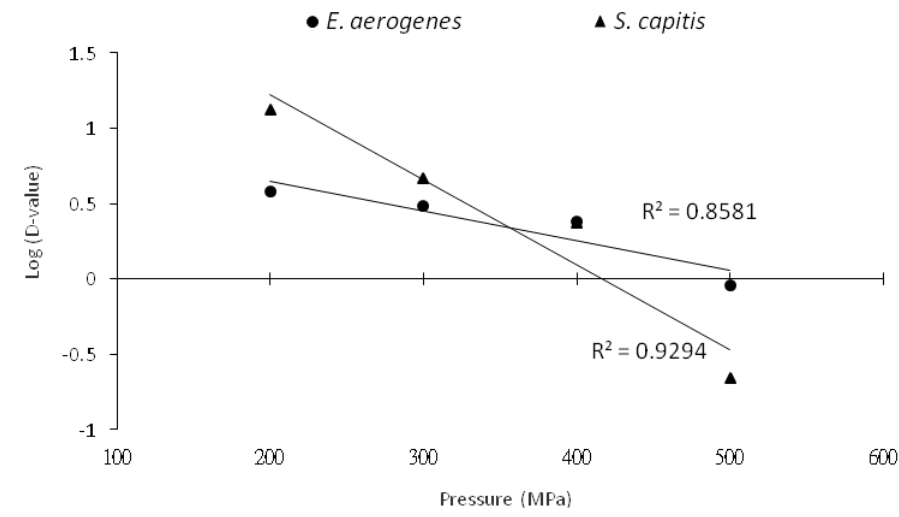
Figure 2. HHP decimal reduction time curves for E. aerogenes and S. capitis in phosphate buffer.